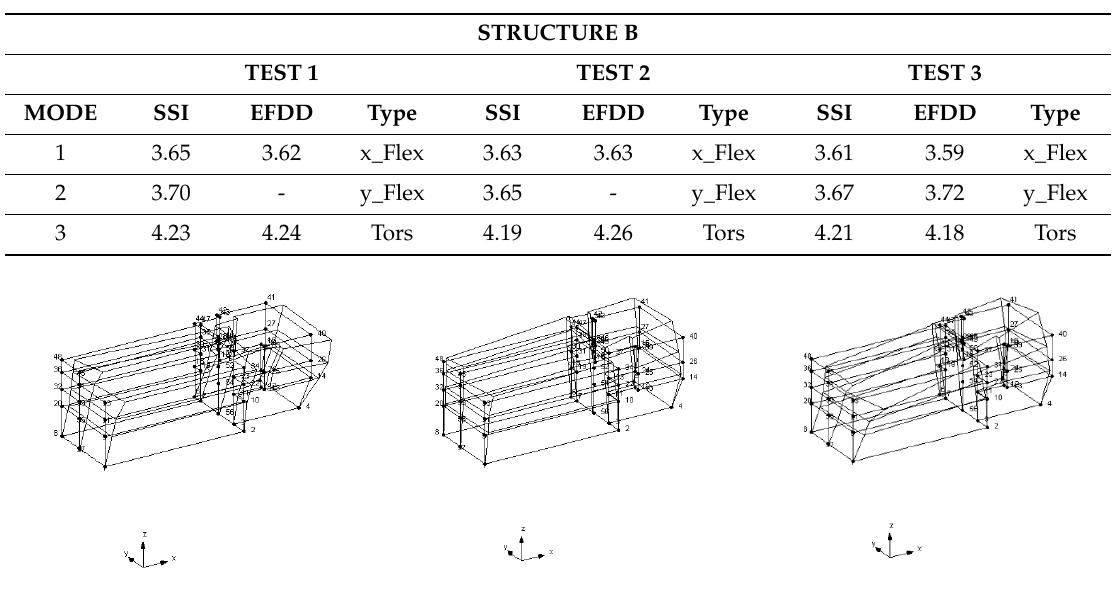
Figure 17. Mode shapes identified with SSI-UPC method—Structure B, Test